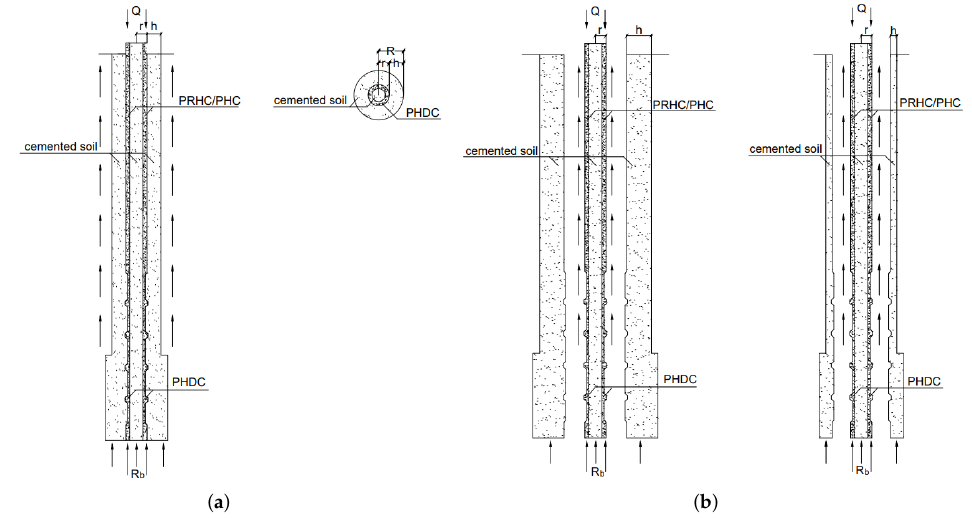
Figure 1. Two failure modes of SDRN pile: ( a ) overall failure mode (pile-cemented soil composite model) and ( b ) core pile penetration failure mode (cemented soil-soil composite model), where Q is the vertical load, and h is the thickness of cemented